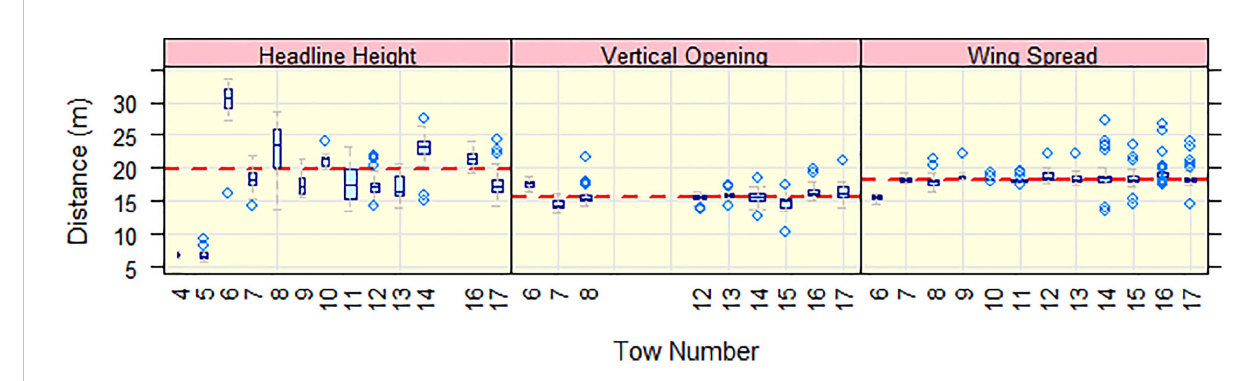
FIGURE 7 OBT net headline height, vertical opening, and wing spread (y-axis) for tows numbers (x-axis) on trip 1 from Notus data. Dashed red lines are the panel medians. Box widths represent the sample sizes within